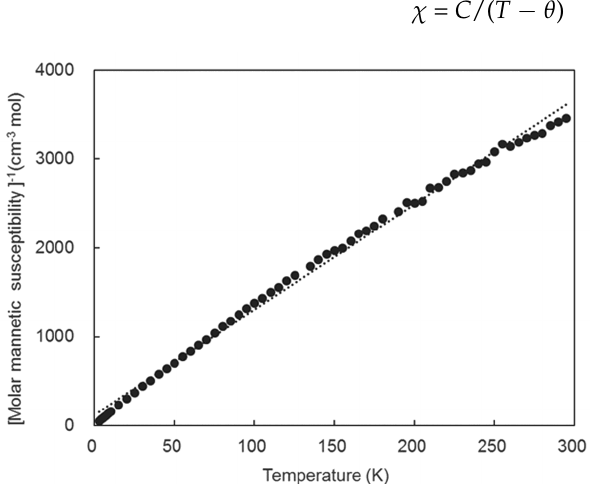
Figure 4 Figure 4. Temperature dependence of the inverse molar magnetic susceptibility for [Ru(apy · − ) 2 (CO) 2